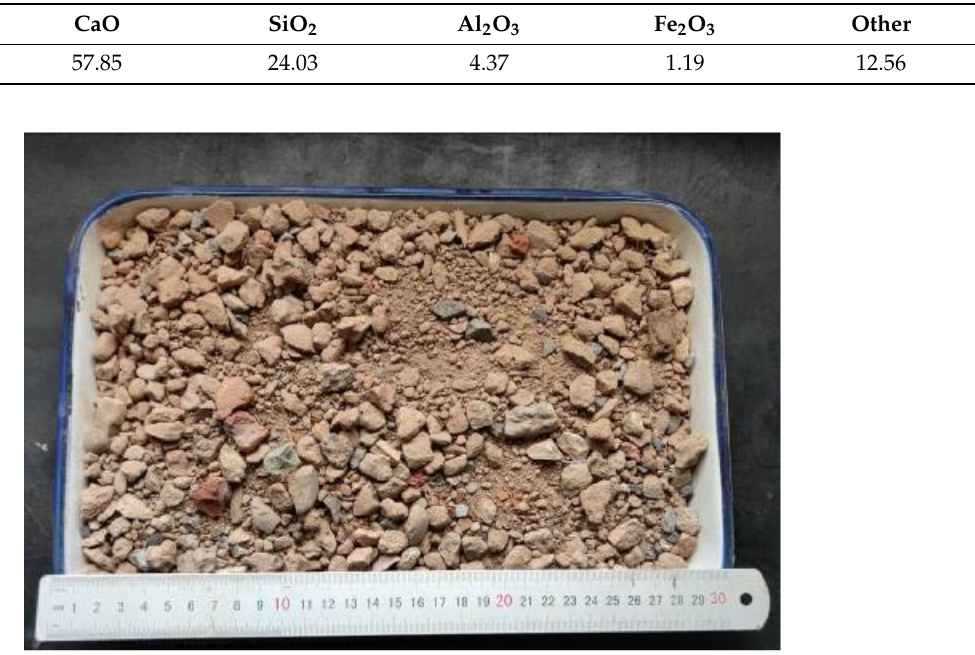
Table 1. Chemical components of limestone.